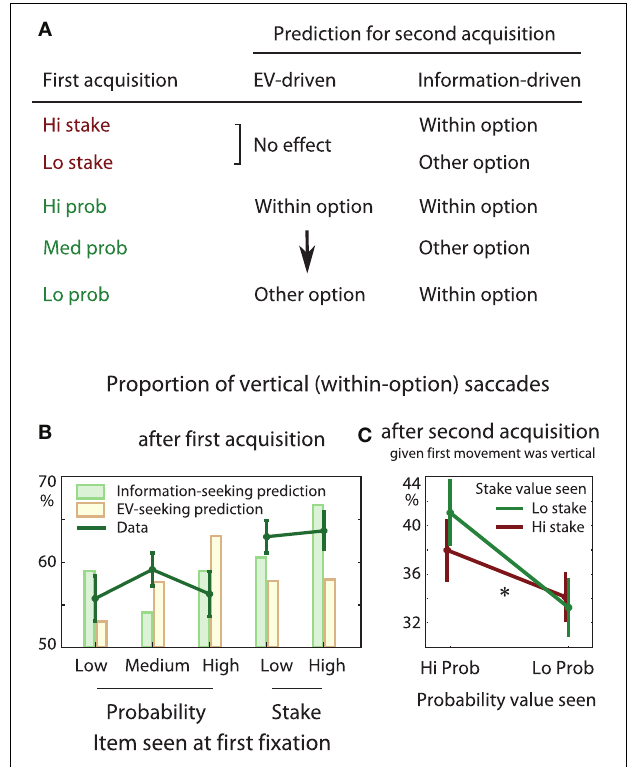
FIGURE 8 | (A) Attention may be guided by EV or by information seeking. The two drives predict different patterns of fixation in our task. If attention were EV -seeking, gaze ought to remain within the current option if the first-seen item was a high probability, but not if it were a low probability. On the other hand, if attention were information-seeking, gaze ought to remain within the current option if a high stake was seen, compared to a low stake. (B) After the first fixation, participants may look vertically within the option, or across to the other option. Where they look next depends on what they just saw: within-option saccades are commoner after seeing a stake. This is predicted when attention is information-driven, rather than EV -driven. Green bars represent the theoretical information gain from making a (cid:10) (cid:9) , within-option saccade, calculated as D KL [ posterior EV || prior EV ] priorp , s which represents how much information one could expect to learn after making a particular saccade. Yellow bars represent the Bayesian estimate of EV of the current option. Both green (information) and yellow ( EV ) bars are arbitrarily scaled. (C) On trials where the first two acquisitions were within one gamble, participants sometimes refixate the first item seen. This is more likely when the probability was high ( p = 0 . 047), but there was no effect of stake ( p > 0 . 05, with no